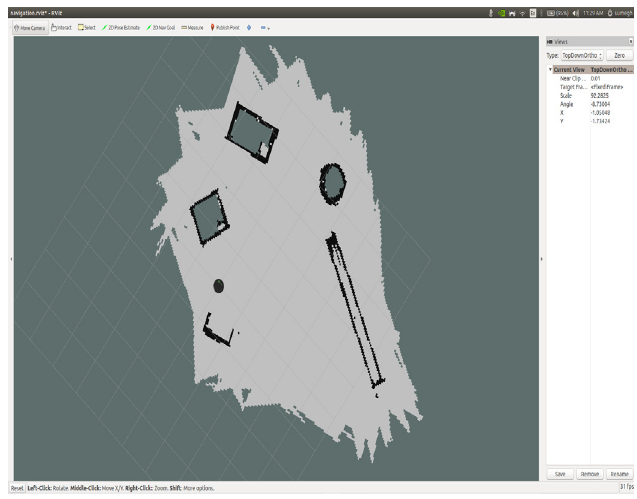
Fig. 3: Visualizing map in rviz